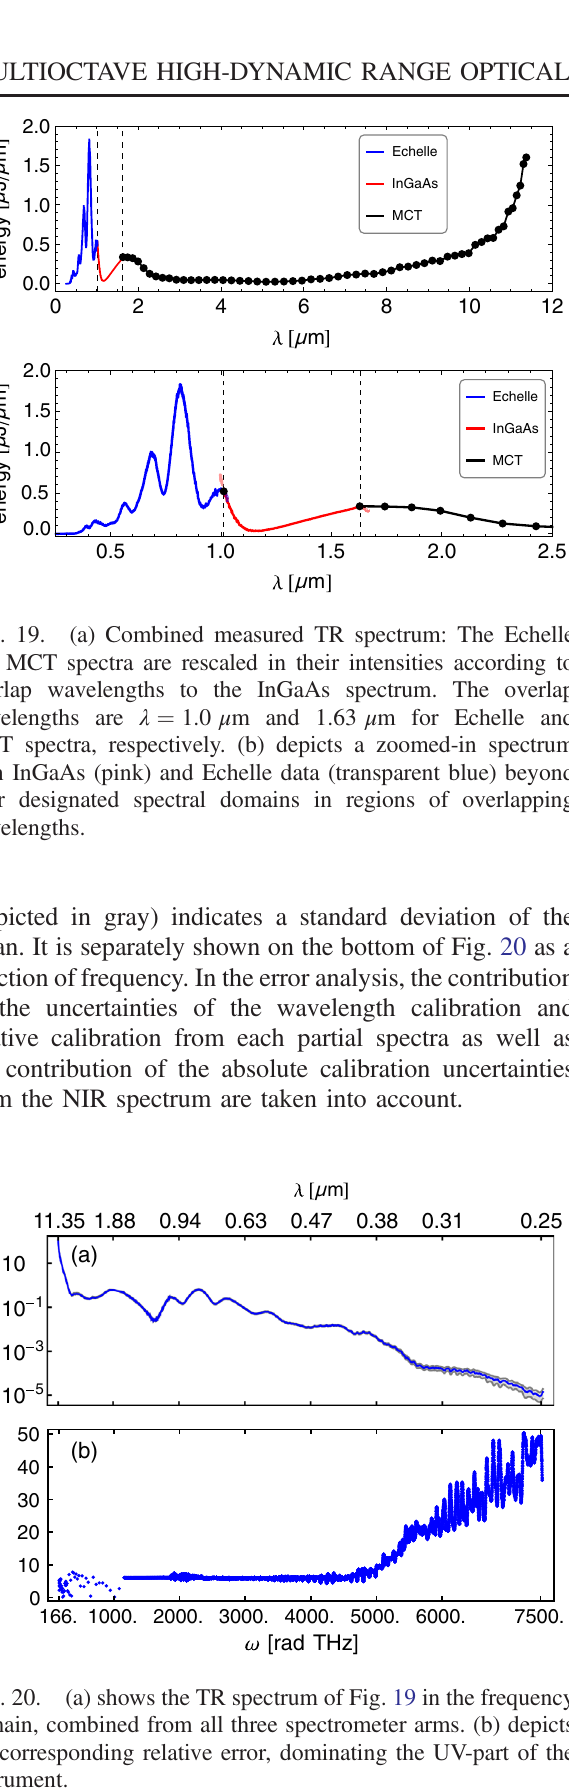
FIG. 20. (a) shows the TR spectrum of Fig. 19 in the frequency domain, combined from all three spectrometer arms. (b) depicts the corresponding relative error, dominating the UV-part of the